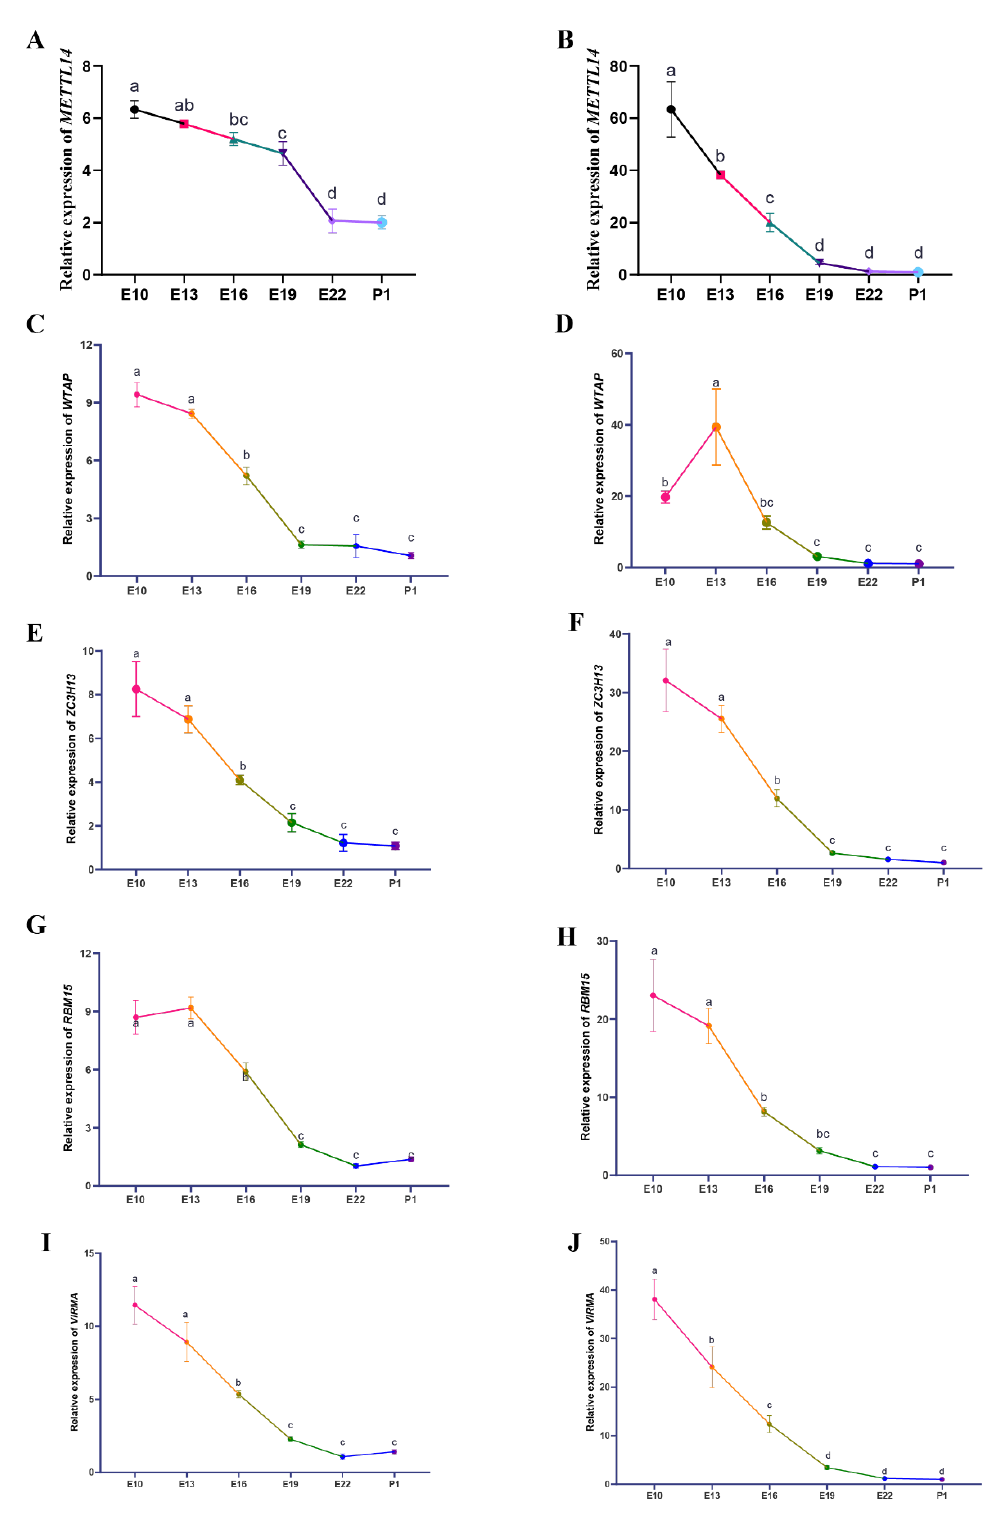
Figure 6. The spatiotemporal expression of METTL14 , WTAP , ZC3H13 , RBM15 , and VIRMA in E10, E13, E16, E19, E22, and P1 during skeletal muscle development. ( A , C , E , G , I ) The expression level of METTL14 and its cofactors in embryonic breast muscle development. ( B , D , F , H , J ) The spatiotemporal expression of m6A-related genes during leg muscle development. In all panels, values are presented as the mean ± S.E.M. Different letters between two groups represent differences that are significant ( p <